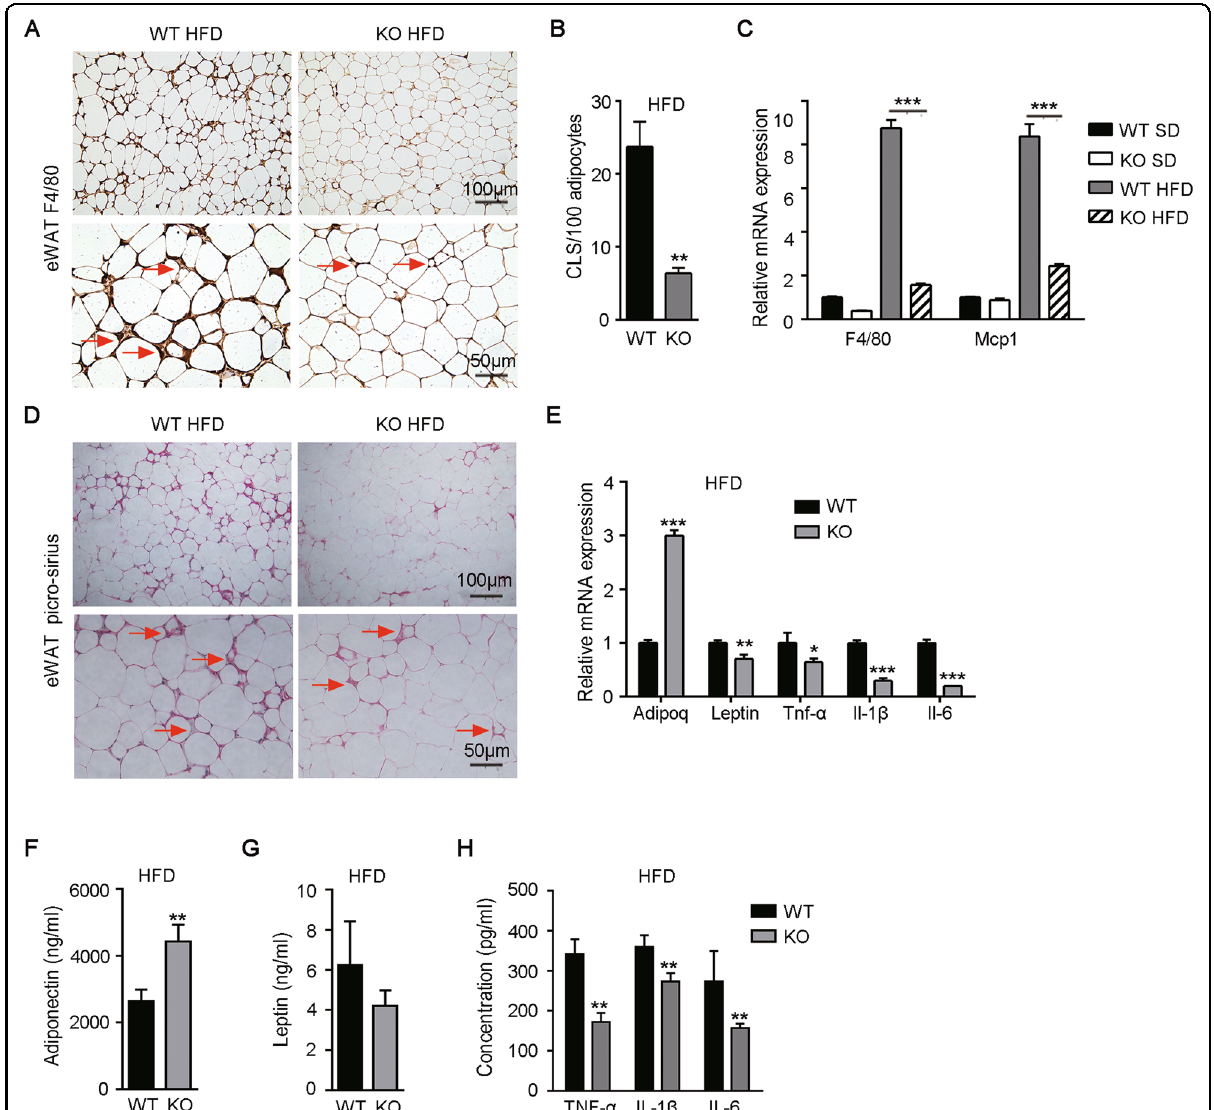
Fig. 4 Gab2 de fi ciency reduces macrophage in fi ltration and in fl ammation in adipose tissue in HFD-fed mice. A Representative immunohistochemistry (IHC) staining images of F4/80 protein in eWAT from Gab2 KO and WT mice fed with HFD diet for 12 weeks. Crown-like structures are indicated by the red arrows. Scale bars are 100 μ m (top) and 50 μ m (bottom). B Quanti fi cation of crown-like structure (CLS) in eWAT from Gab2 KO and WT mice fed with HFD diet for 12 weeks. C The mRNA level of F4/80 and Mcp-1 in eWAT from Gab2 KO and WT mice fed with SD or HFD diet for 12 weeks were detected by RT-qPCR. The results were normalized with S18 mRNA levels. D Representative picro-sirius staining images of collagen fi brils in eWAT from Gab2 KO and WT mice fed with HFD diet for 12 weeks. Collagen fi brils are indicated by the red arrows. Scale bars are 100 μ m (top) and 50 μ m (bottom). E The mRNA level of adiponectin ( Adipoq ), leptin , and in fl ammation cytokines ( Tnf- α , Il-1 β , Il-6 ) in eWAT from Gab2 KO and WT mice fed with HFD diet for 12 weeks detected by RT-qPCR. The results were normalized with S18 mRNA levels. F – H The concentration of adiponectin ( F ), leptin ( G ), and in fl ammation cytokines (TNF- α , IL-1 β , IL-6, H) in blood plasma samples analyzed by ELISA assay. The data are presented as mean ± SD from at least 6 mice in each group. Statistical difference is indicated: * P < 0.05; ** P < 0.01; *** P <